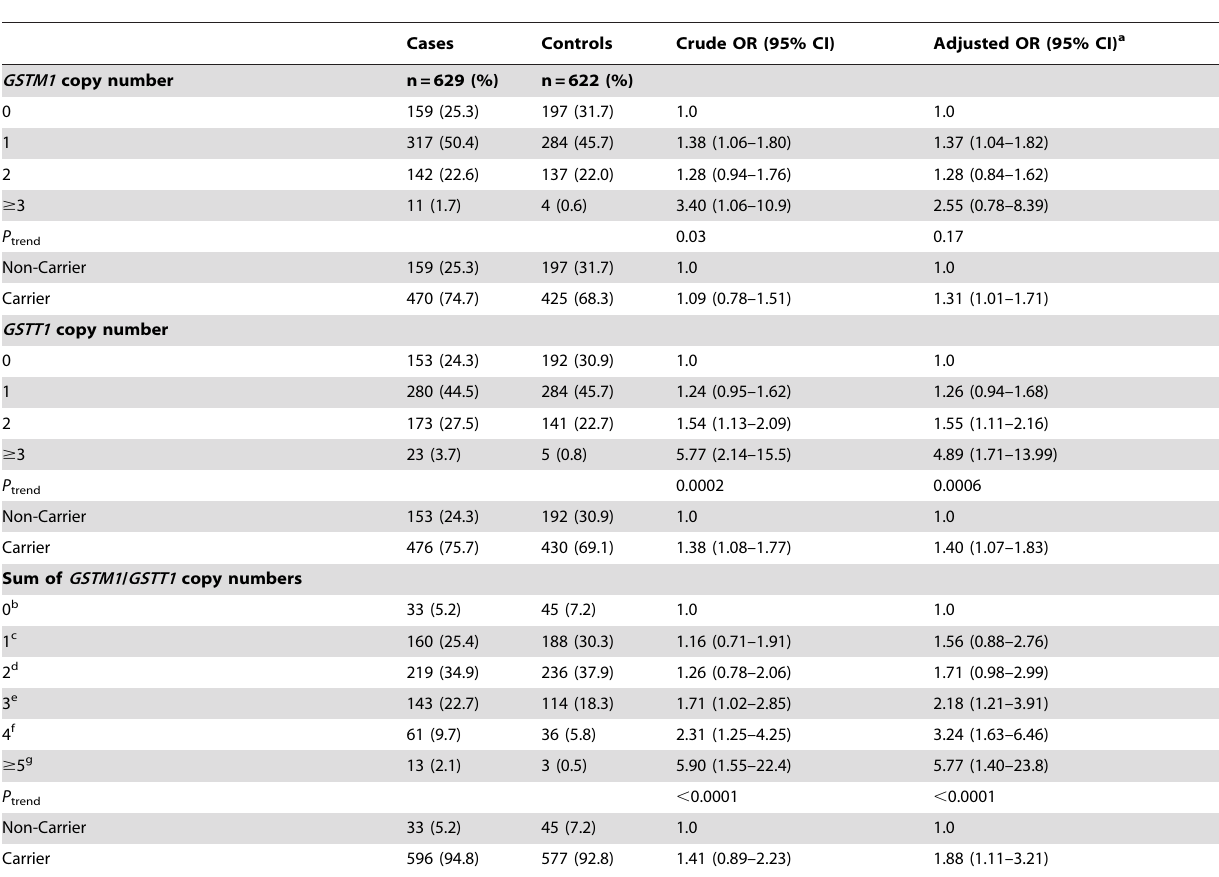
Table 2. Association between copy number of the GSTM1 and GSTT1 genes and risk of prostate